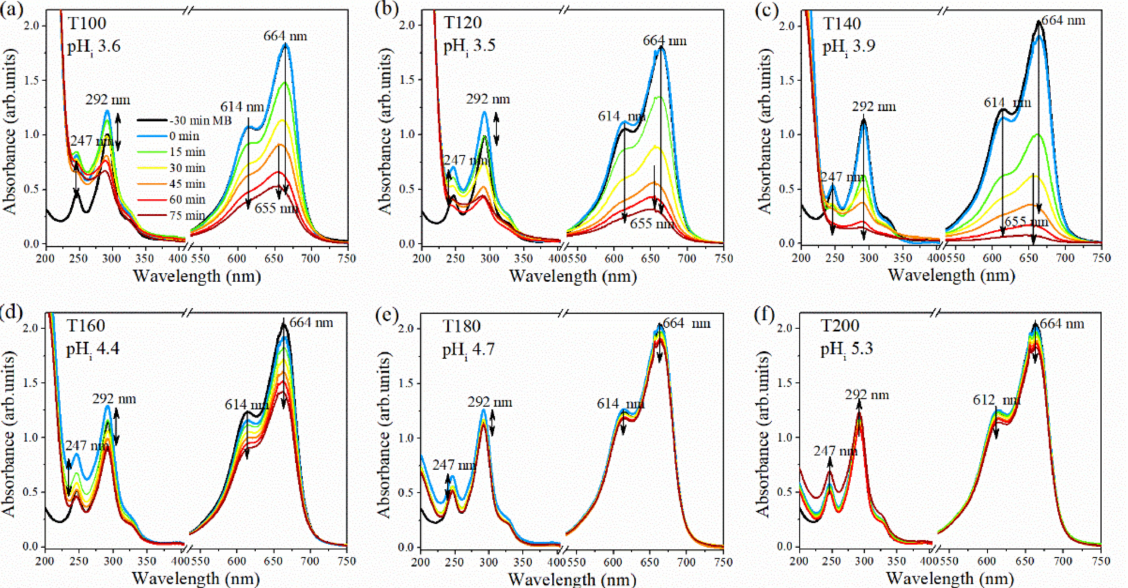
Figure 7. Time dependent UV-Vis absorption spectra depicting the degradation of MB solutions catalyzed by micro-mesoporous TiO 2 samples: ( a ) T100, ( b ) T120, ( c ) T140, ( d ) T160, ( e ) T180, and ( f )